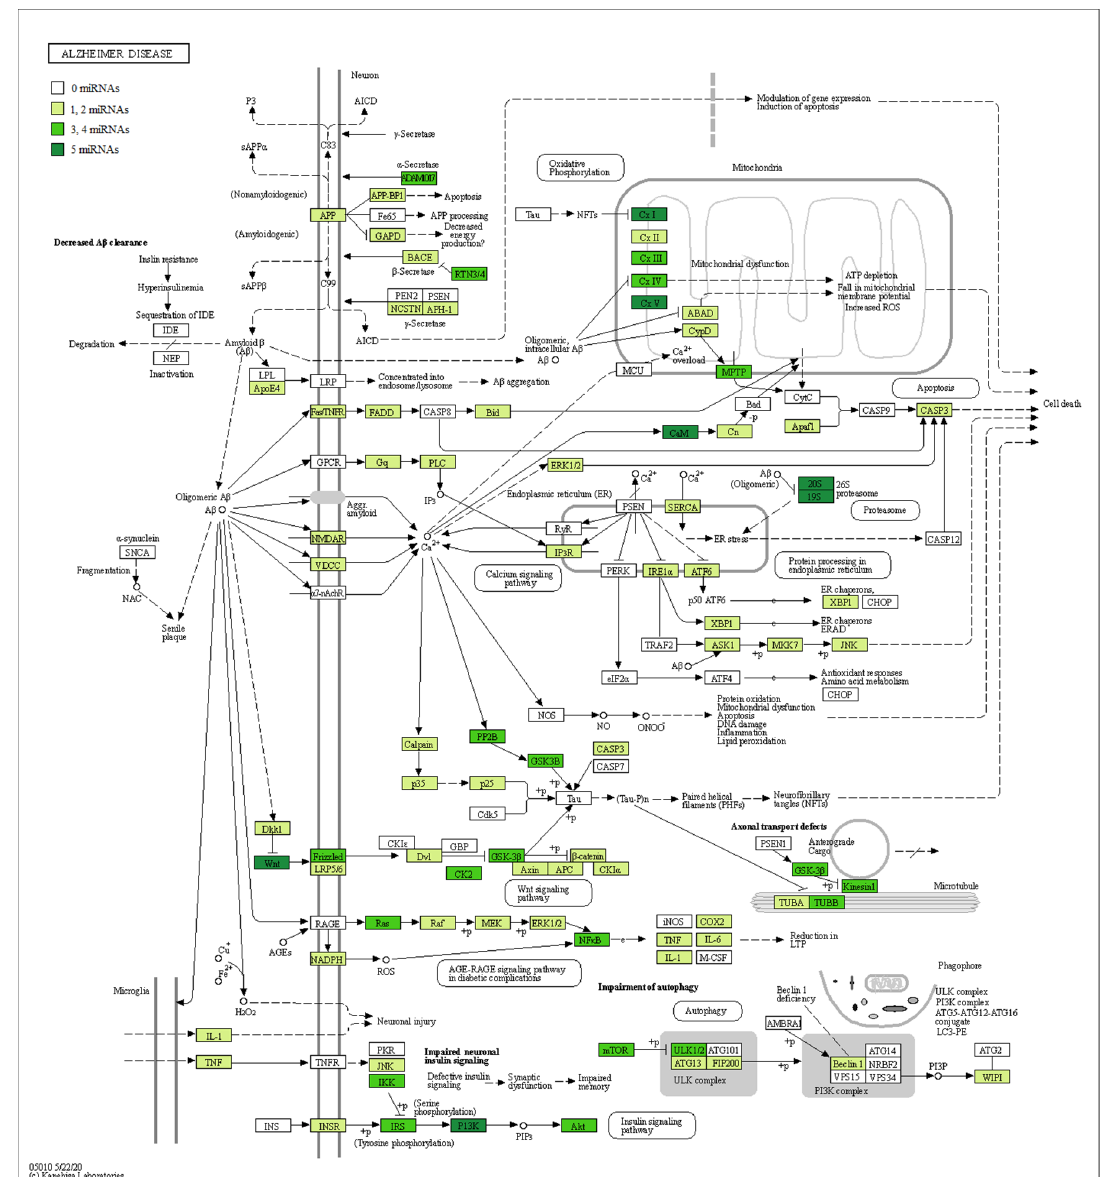
Figure 3. AD pathway with target genes of upregulated miRNAs highlighted. The schema represents the AD pathway in KEGG. The green scale represents the proteins encoded by genes known to be targets of the upregulated miRNAs. A darker color green, indicates a greater number of miRNAs that target the genes encoding that specific protein. If the protein is white, no miRNA targets any gene there. In particular, given that miRNAs are upregulated in our analysis, we can expect these genes to be downregulated.